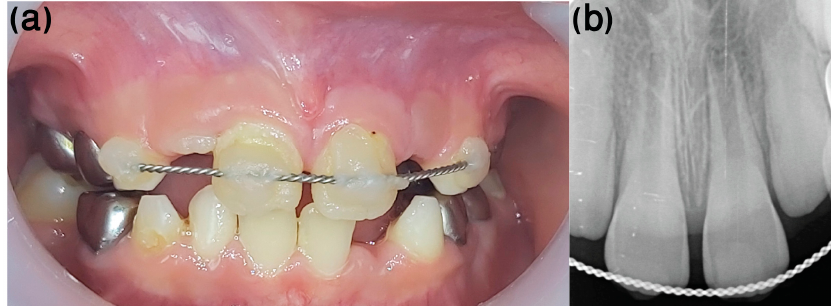
Figure 2. Case 1, one week post-injury. ( a ) Clinical and ( b ) radiologic appearance one week following avulsion, re-implantation, and splinting of tooth #21.